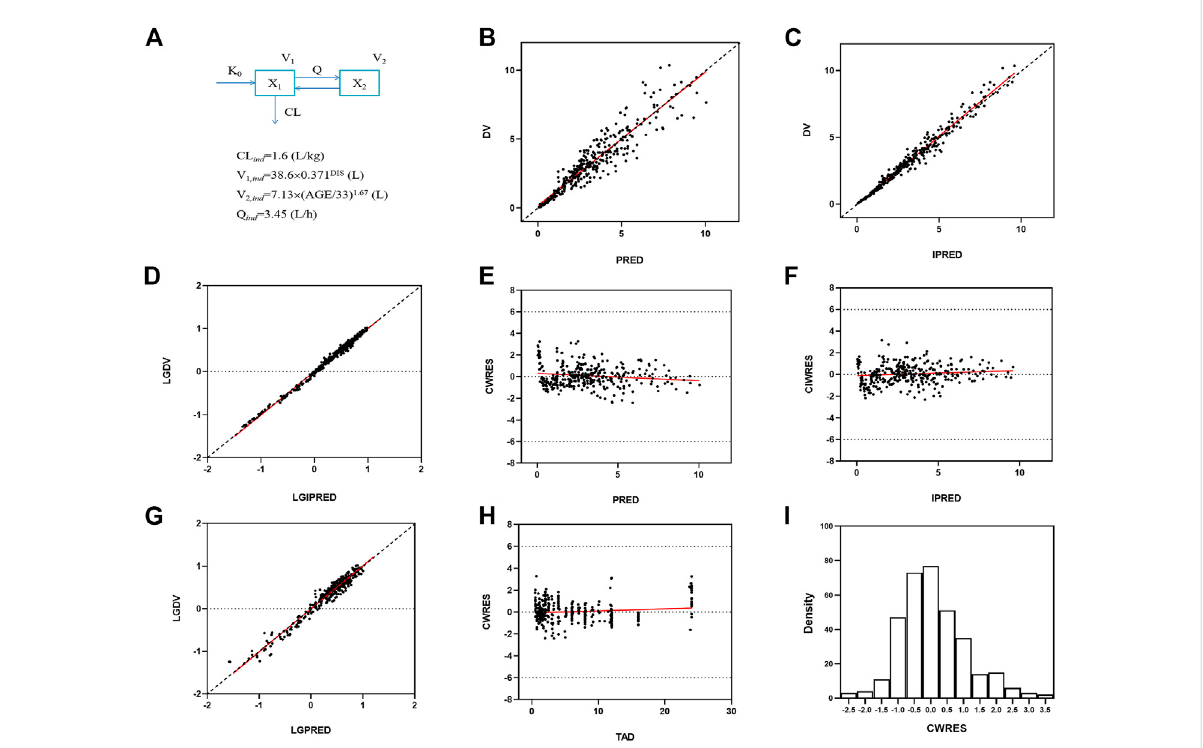
Goodness-of- fi t plots for the fi nal population PK model. Predicted concentrations are in micrograms per liter and time is in hours. (A) PPK model schematic fi gure and fi nal model, DIS = 1 for patients and DIS = 2 for healthy subjects; (B) Observed polymyxin B concentrations (DV) versus population predictions (PRED). (C) DV versus individual predictions (IPRED). (D) Log transformed DV versus Log transformed IPRED. (E) Conditional weighted residuals (CWRES) versus PRED. (F) Conditional individual weighted residuals (CIWRES) versus IPRED. (G) Log transformed DV versus Log transformed PRED. (H) CWRES versus time after dose (TAD). (I) distribution of